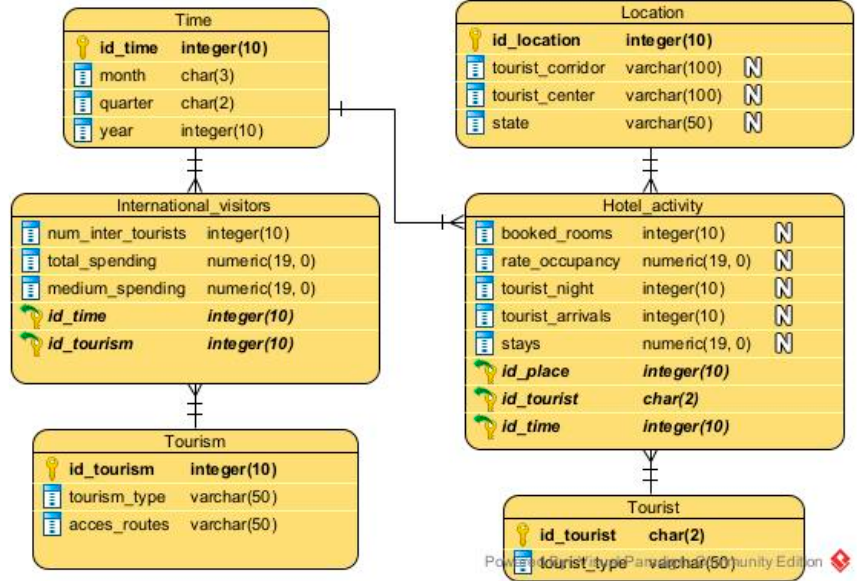
Figure 5. The multidimensional model of the tourist DW. Table 9. Tables of a tourist DW.